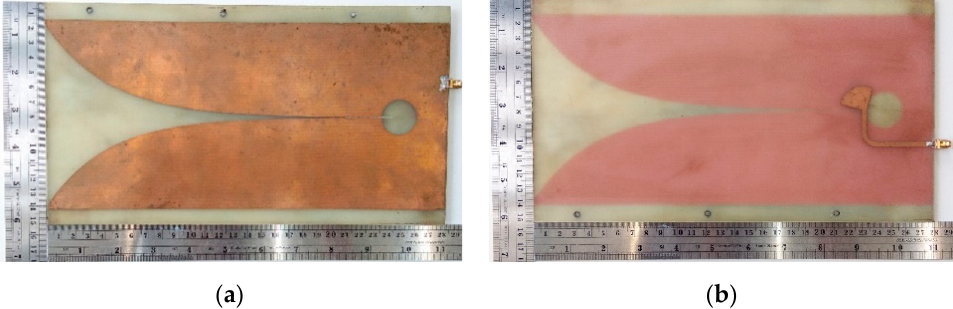
Figure 2. The Tx and Rx Vivaldi prototype antennas: ( a ) top view; ( b ) bottom view with the radiator.